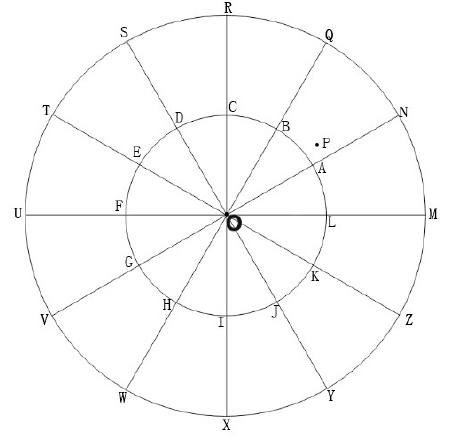
Figure 5. Viewpoint target plate design drawing.